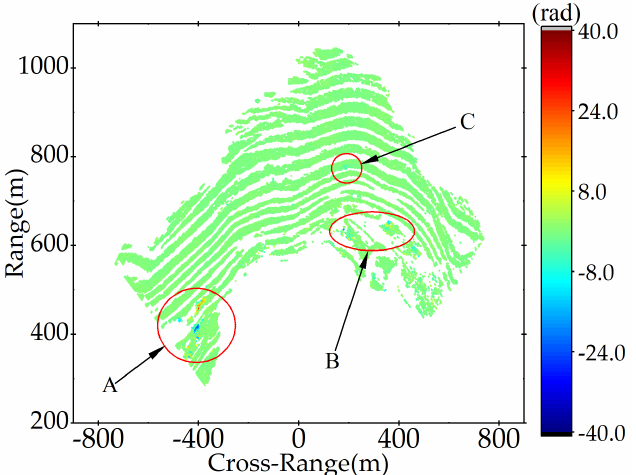
Figure 23. Final cumulative results after correction of all interferograms. During the data acquisition, the bottom of the mine was being mined normally, and there were mining trucks in A and B, and A is the main operation area. Therefore, the phase changes in these two areas were mainly caused by mechanical operations and are not natural deformations. Among the seven marked small areas, #3, #4, and #7 have significant deformation, and their median curves of CP are shown in Figure